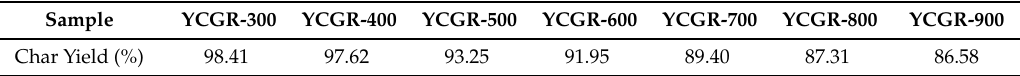
Table 3. Char yields of the coal sample at different pyrolysis